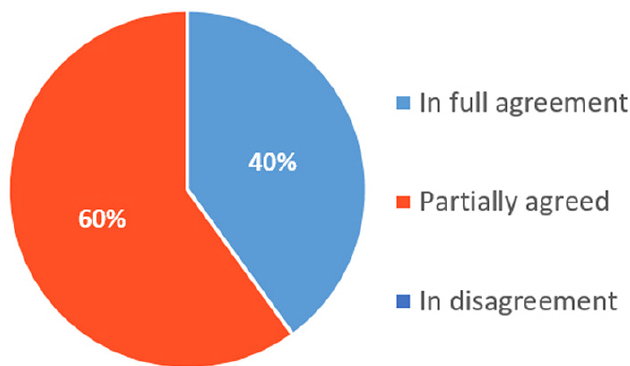
Fig. 13. Percentage of students who report that the new laboratory equipment acquired allows them to have a better understanding of the subjects addressed in the